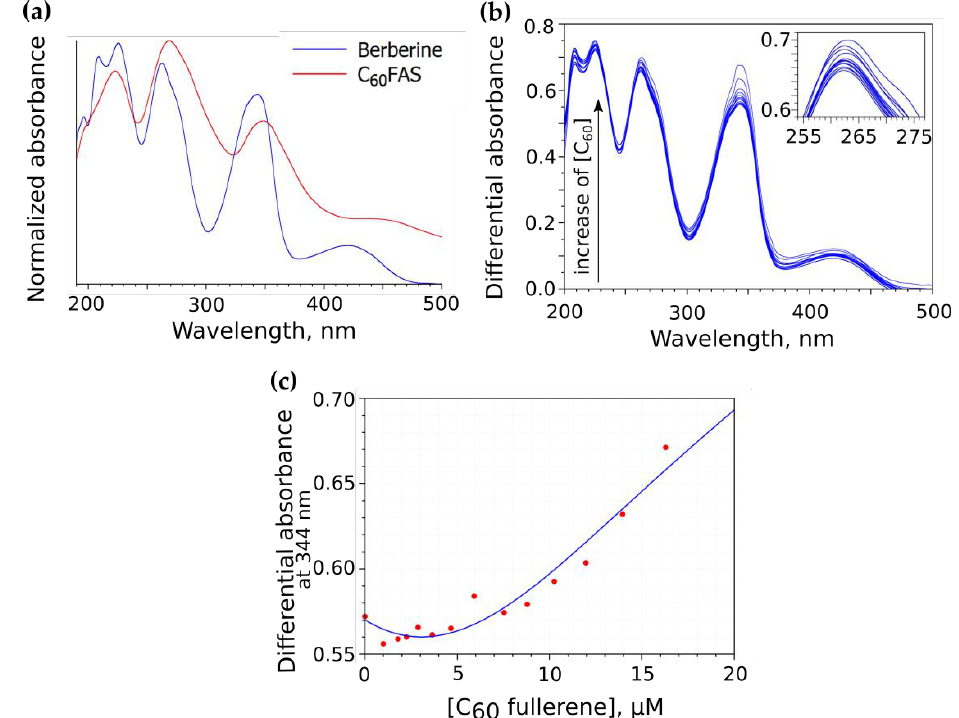
Figure 3. Absolute absorption spectra of Ber and C 60 ( a ), differential absorption spectrum of C 60 -Ber nanocomplex solution ( b ), and the differential absorbance measured at absorption maximum of Ber molecule and fixed Ber concentration, C D 0 = 0.02 mM, as a function of C 60 concentration ( c ).